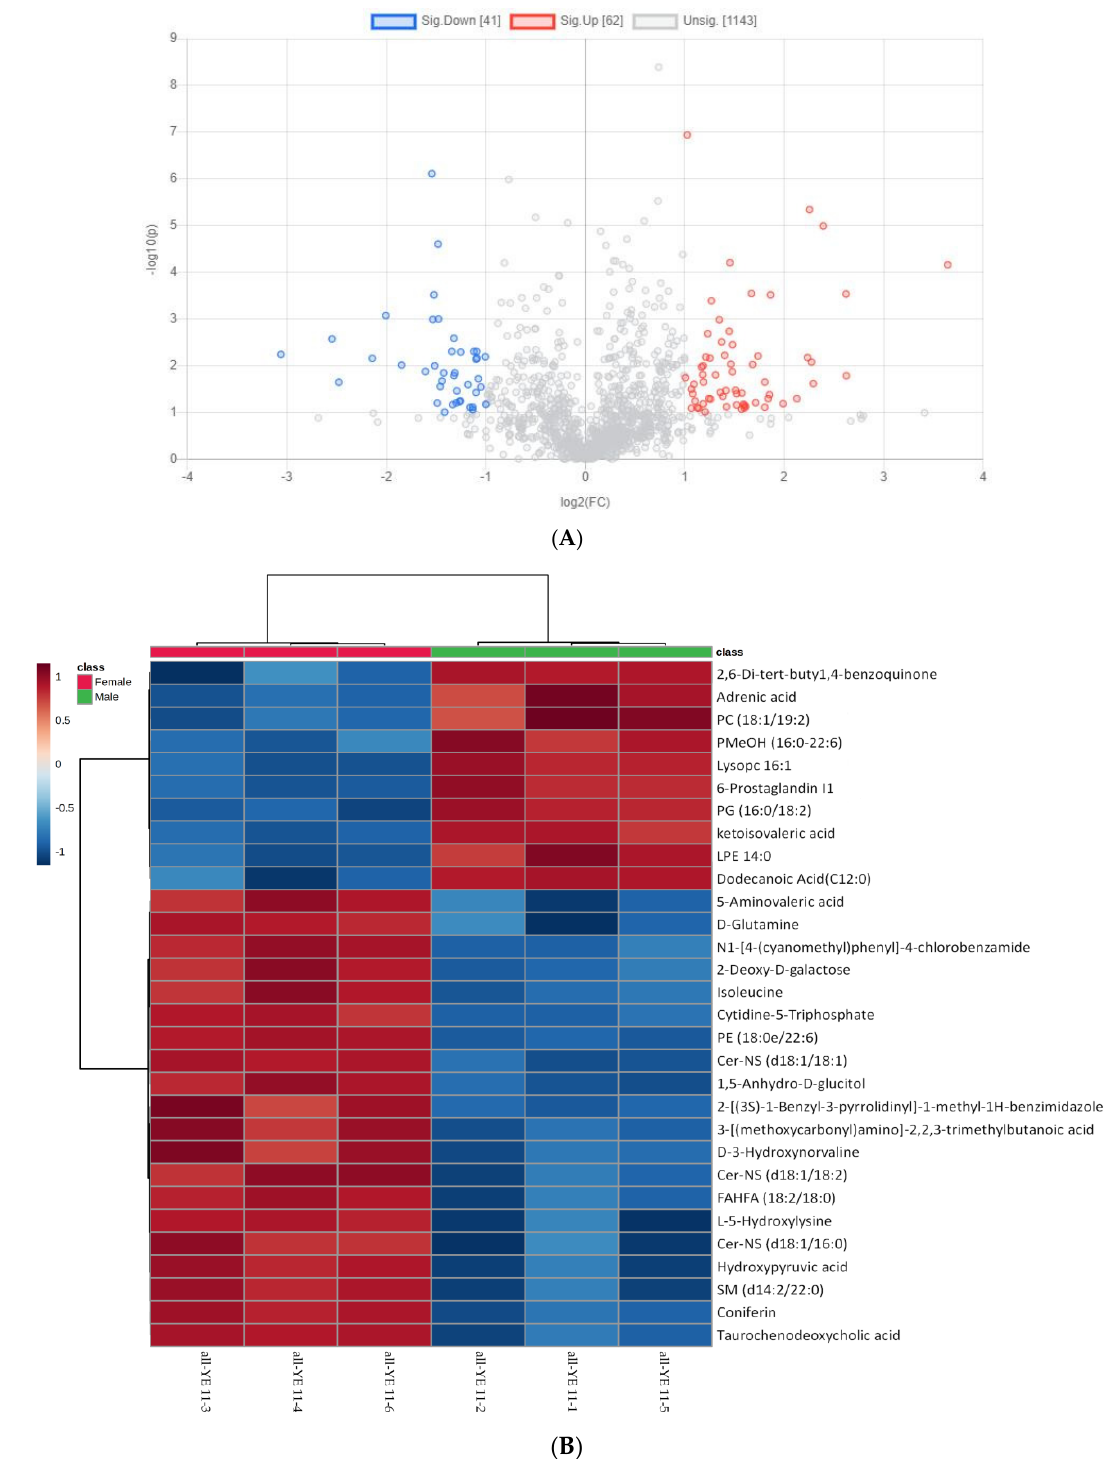
Figure 3. Differential yolk metabolites identified from male and female chicken embryos at E11 ( n = 3). ( A ) The volcano plot shows the combination of the fold changes and the p values of each metabolite. The red dots represent the metabolites that were significantly upregulated in female birds, while the blue dots represent the metabolites that were significantly downregulated in female birds. ( B ) Heatmap showing the difference profile of yolk metabolites between male and female chicken embryos. Each cell in the plot corresponds to a normalized z-score value. Sample names are in columns and compound names are in rows.